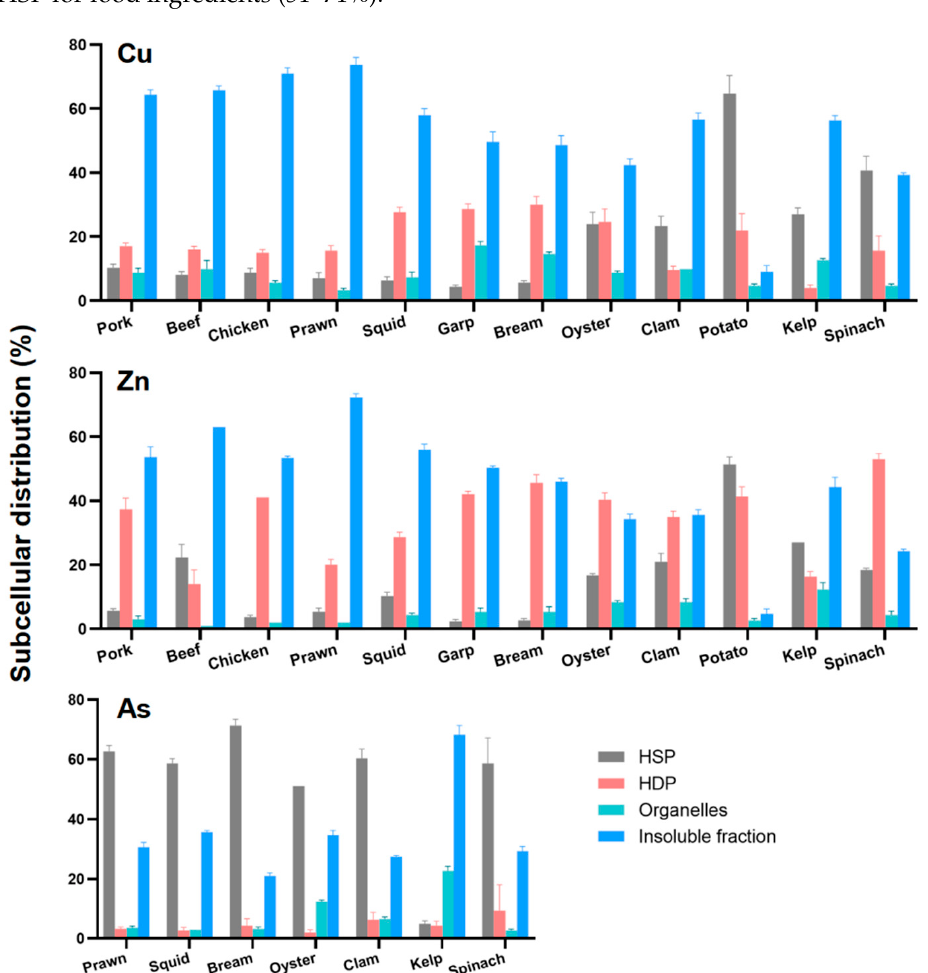
Figure 2. The subcellular distribution of Cu, Zn, and As in the raw food ingredients. HSP: heat-stable proteins; HDP: heat-denatured proteins; insoluble fraction: cellular debris + metal-rich granules. Data are expressed as means ± SD ( n = 3).